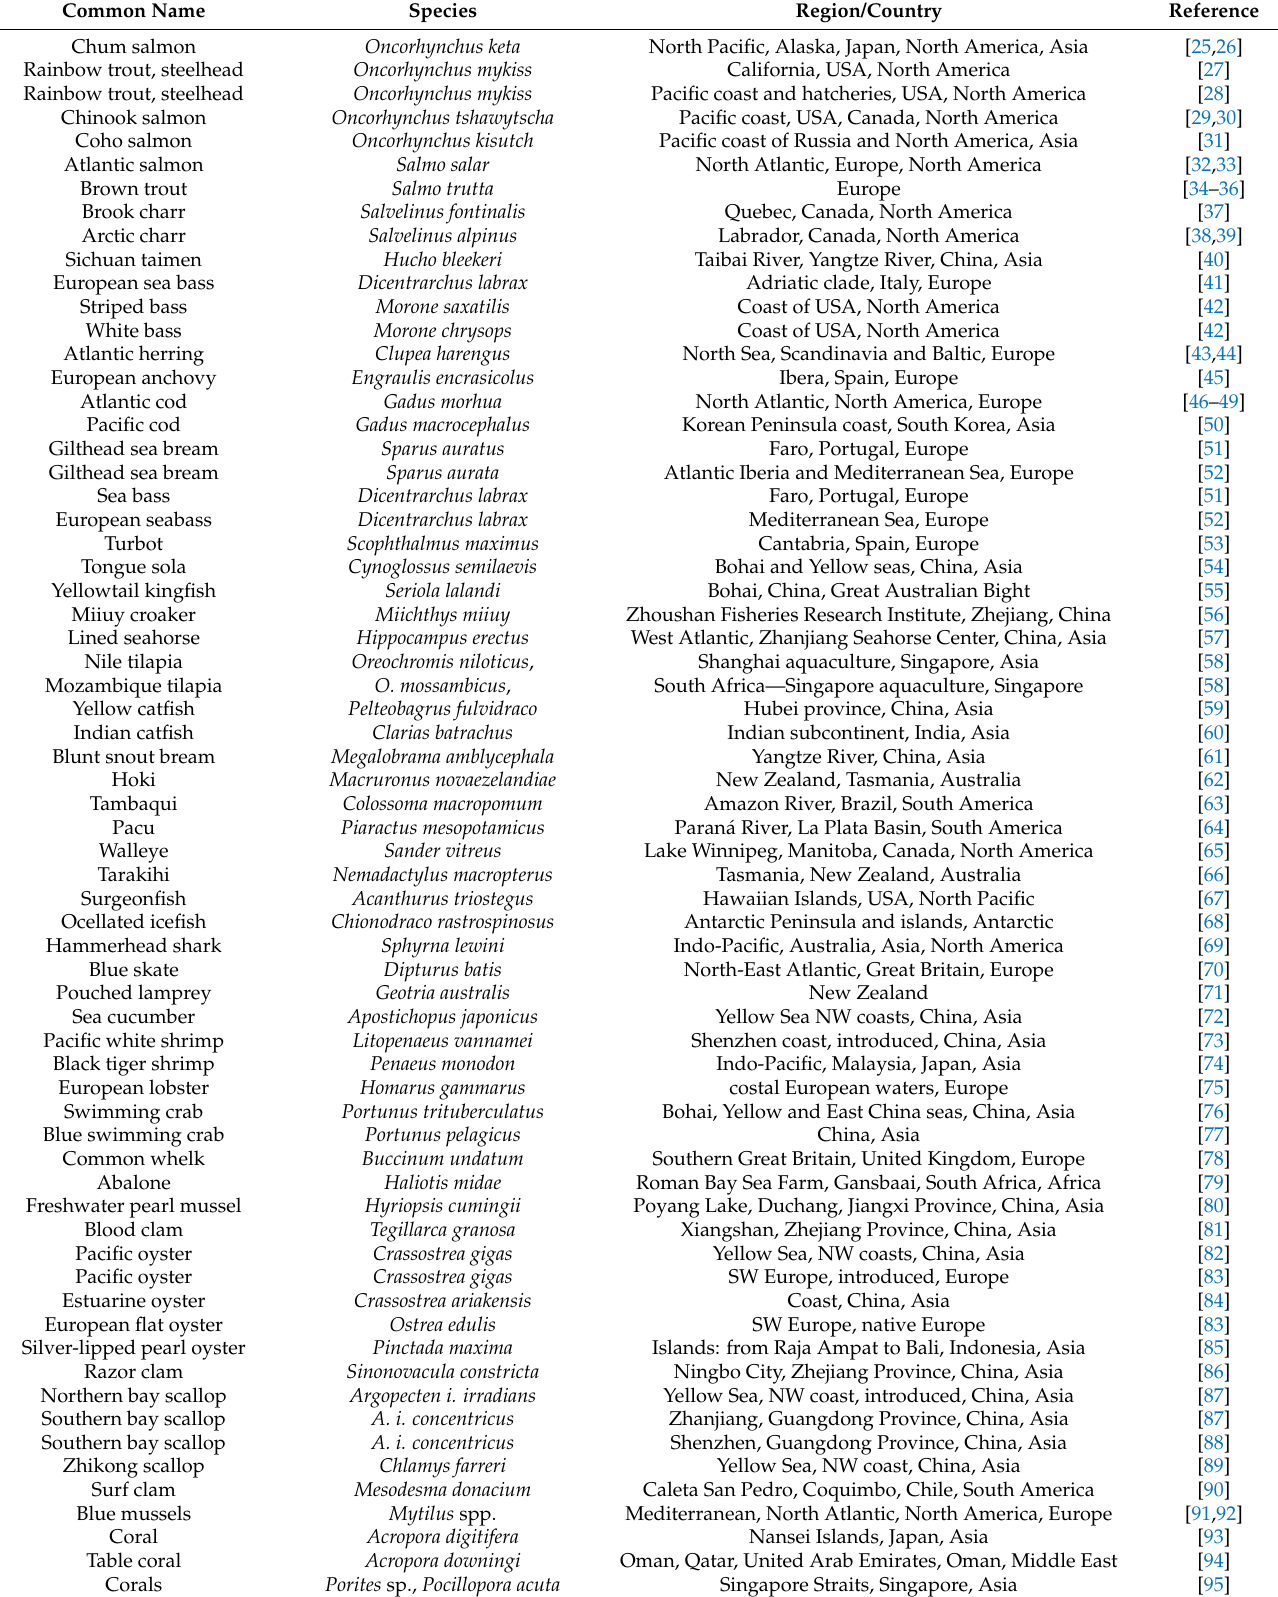
Table 1. List of species with sets of SNPs reported for the genetic structure studies of wild populations. Common